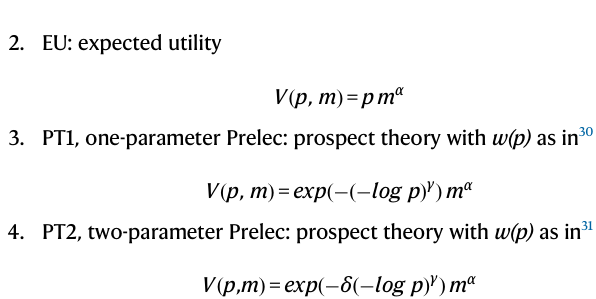
Cue the maximum fi ring rates. P and M indicate the probability and magnitude of rewards, respectively. g Color map of the neural fi ring rates during the 1s time window in b for ten levels of probability and magnitude of rewards. Average smoothing was made between neighboring pixels. h Percentage of neurons modulated by probability and magnitude of rewards in the four core reward brain regions. Gray indicates activity showing positive regression coef fi cients for prob- ability and magnitude of rewards (P+M+type). Black indicates activity showing the negative regression coef fi cients for probability and magnitude (P-M- type). Images in panels a were created by the authors and previously published in Neural Population Dynamics Underlying Expected Value Computation. Hiroshi Yamada, et al. 28 .